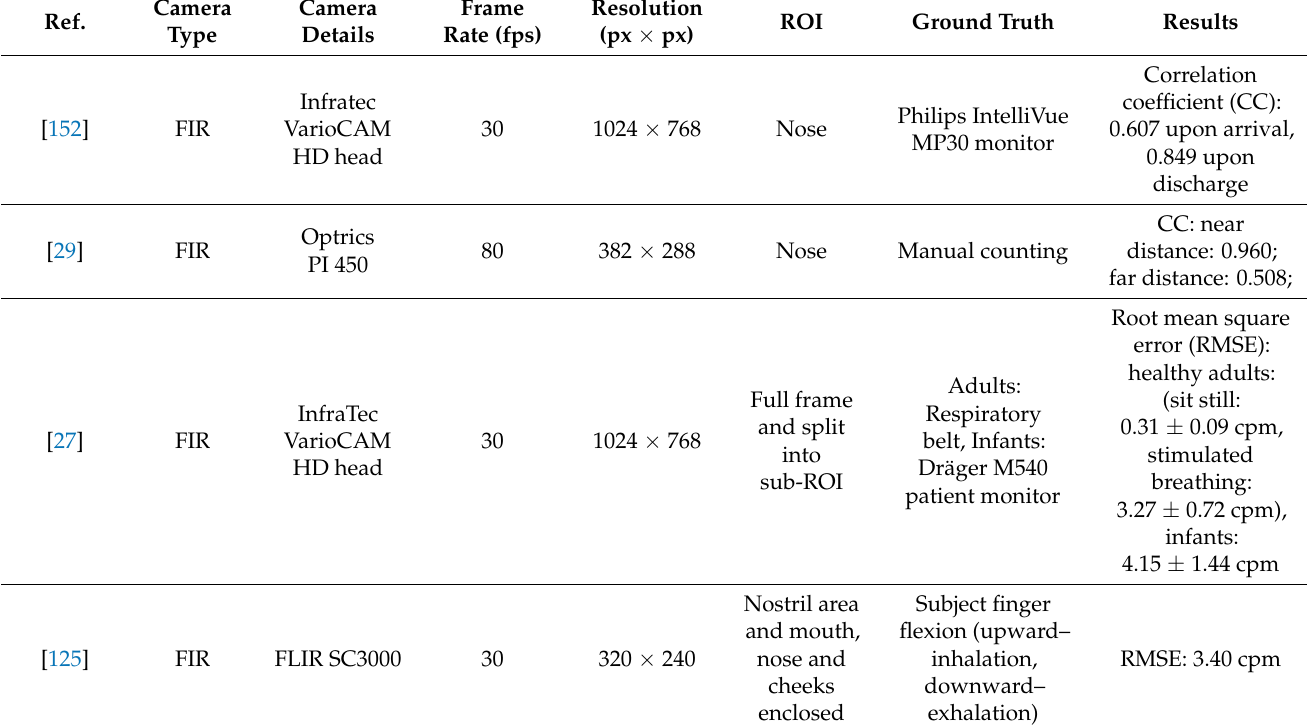
Table 6. Studies using RR by utilizing camera-based